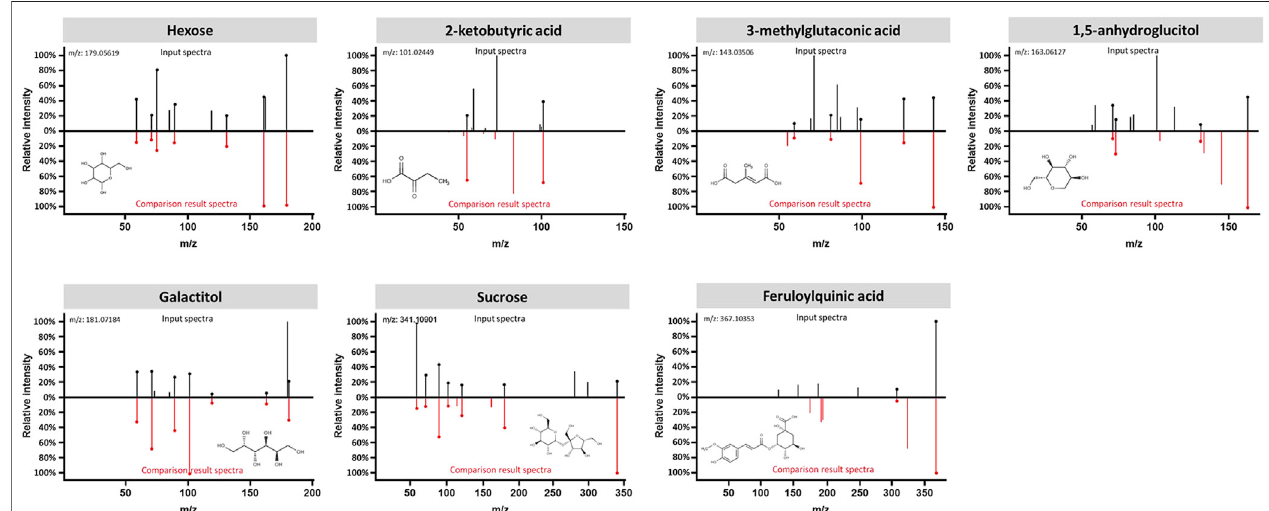
FIGURE 2 | Structural identi fi cation of the biomarker compounds discovered from global metabolomics analysis: Hexose, 2-ketobutyric acid, 3-methylglutaconic acid, 1,5-anhydroglucitol, Galactitol, Sucrose, and Feruloylquinic acid. Measured MS/MS spectral fragmentation pro fi les (top, in black) matching procured chemical standards (bottom, in red) pro fi led with the same LCMS